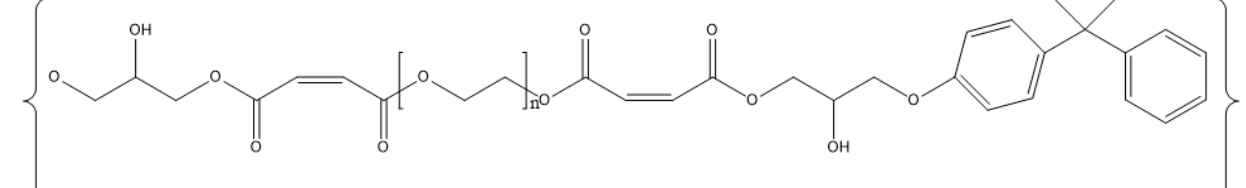
Figure 1. Chemical structure of MP8B polymer.